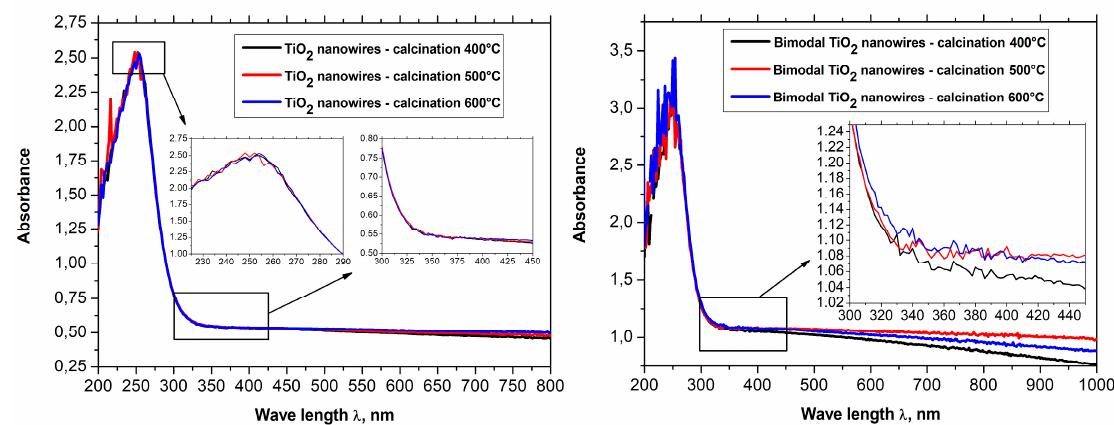
Figure 11. UV-Vis spectra obtained for ( a ) TiO 2 nanowires and ( b ) bimodal TiO 2 nanowires.